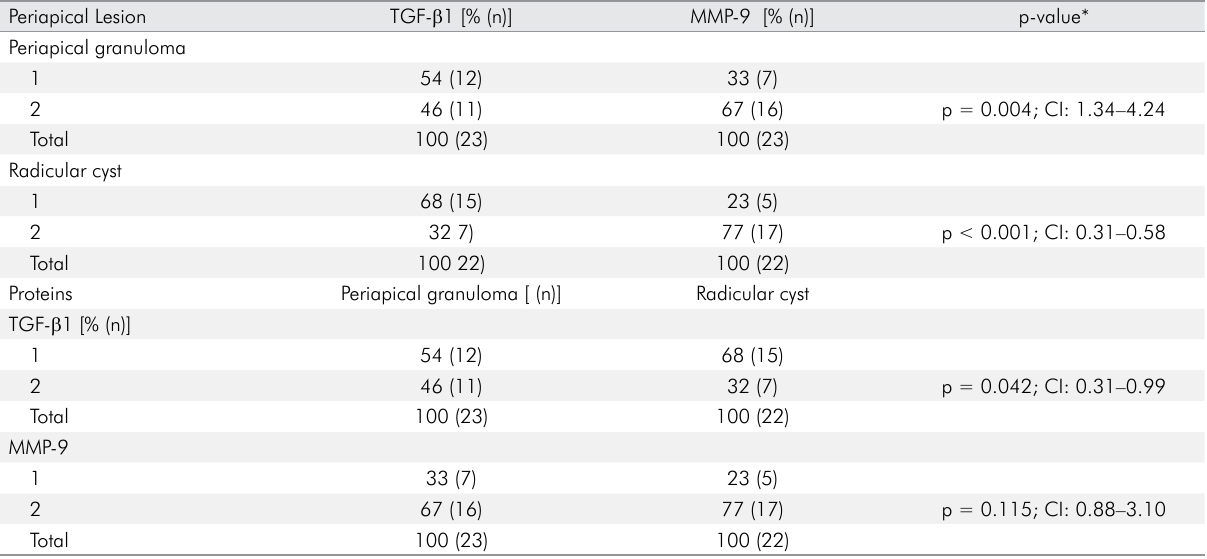
Table 2. Distribution of immunohistochemical expression scores of TGF- β 1 and MMP-9 in periapical granulomas and radicular cysts Periapical